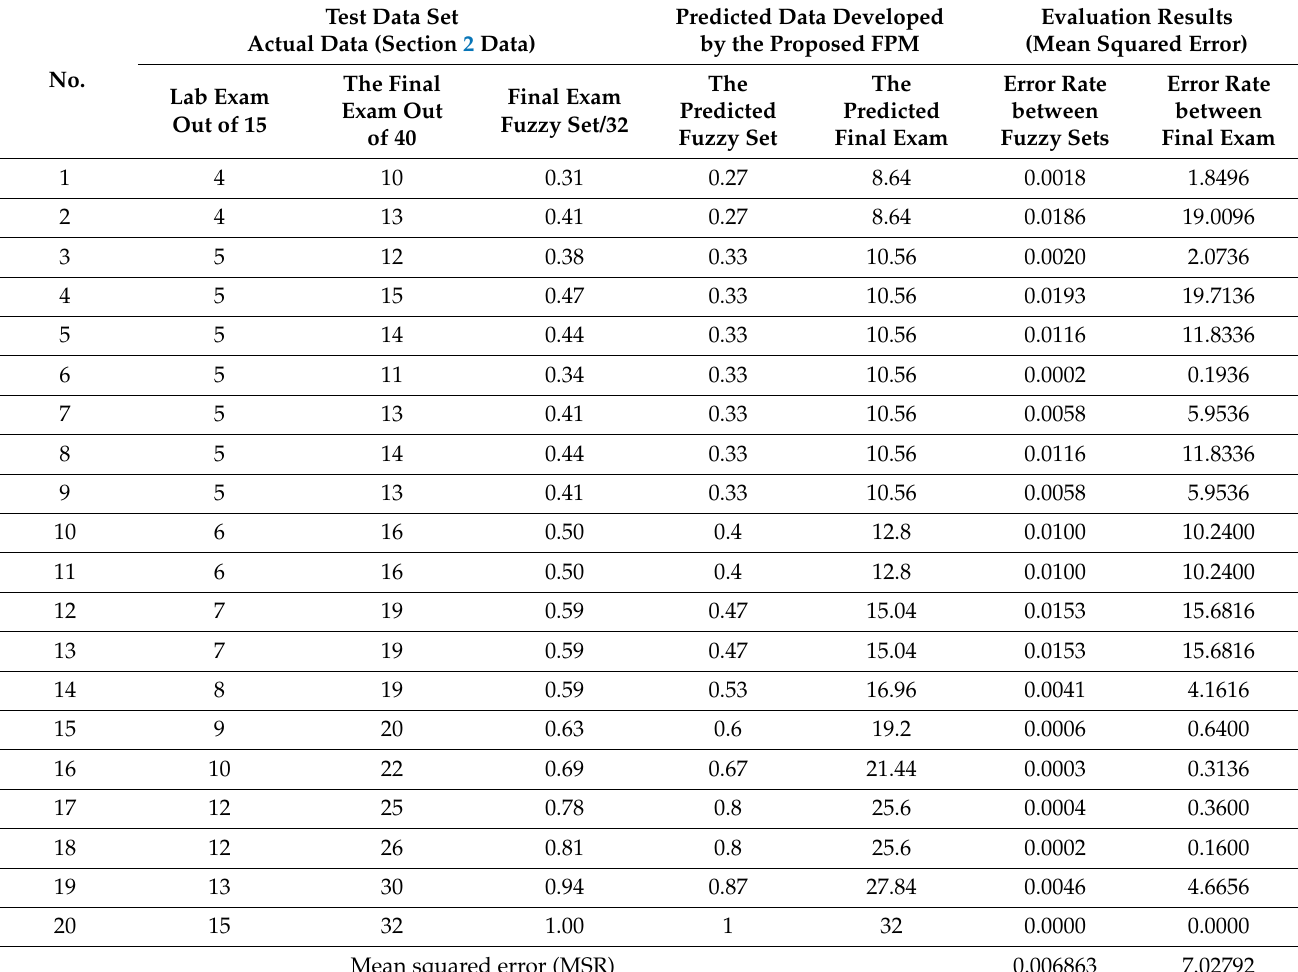
Table 7. The results of testing FPM on related data sets—the second experiment (Section 4.2).